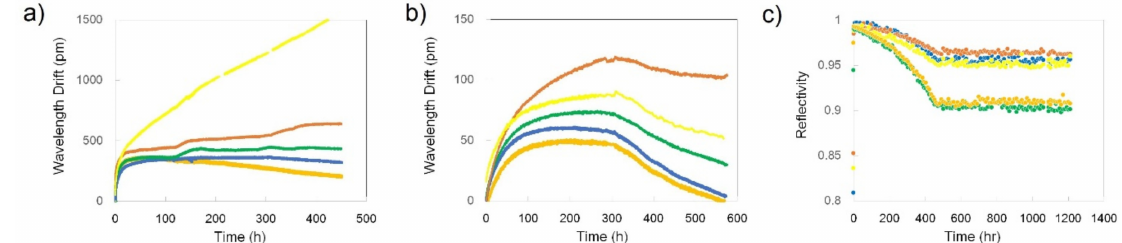
Figure 25. ( a ) Wavelength drift of Type-c FBGs at 1000 ◦ C, ( b ) Wavelength drift at 900 ◦ C of the Type-c FBGs that were pre-annealed at 1000 ◦ C and shown in ( a ), ( c ) Type-c FBGs reflectivity change during annealing at 1000 ◦ C and 900 ◦